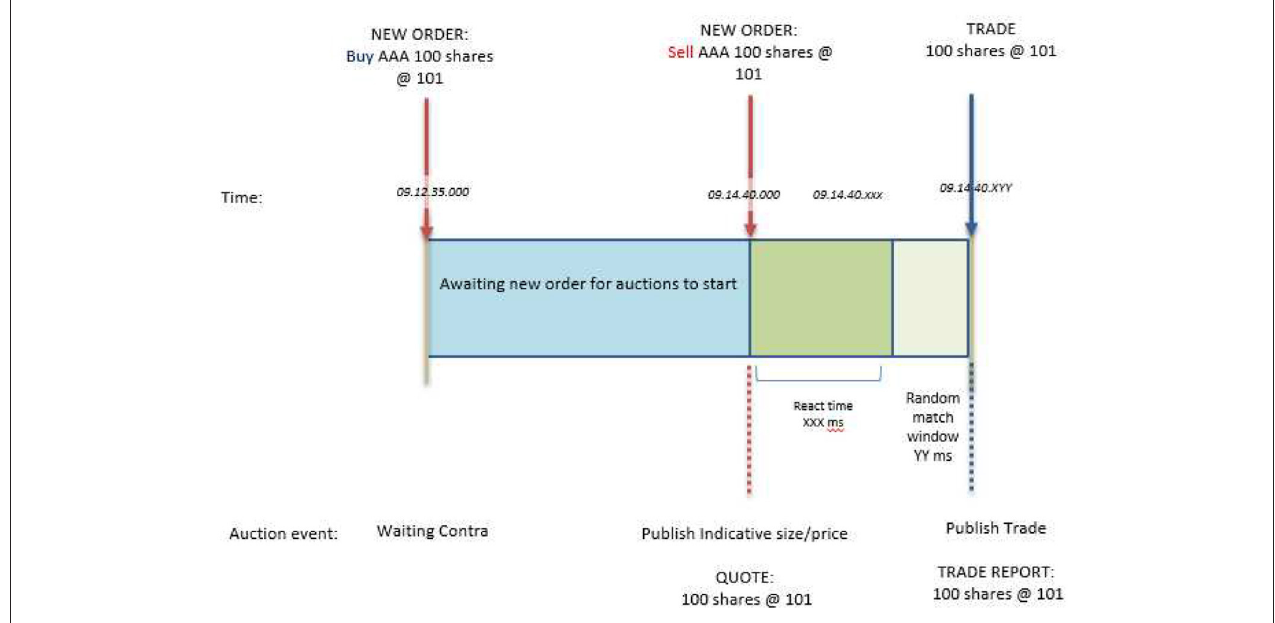
FIGURE 4 | Auction time